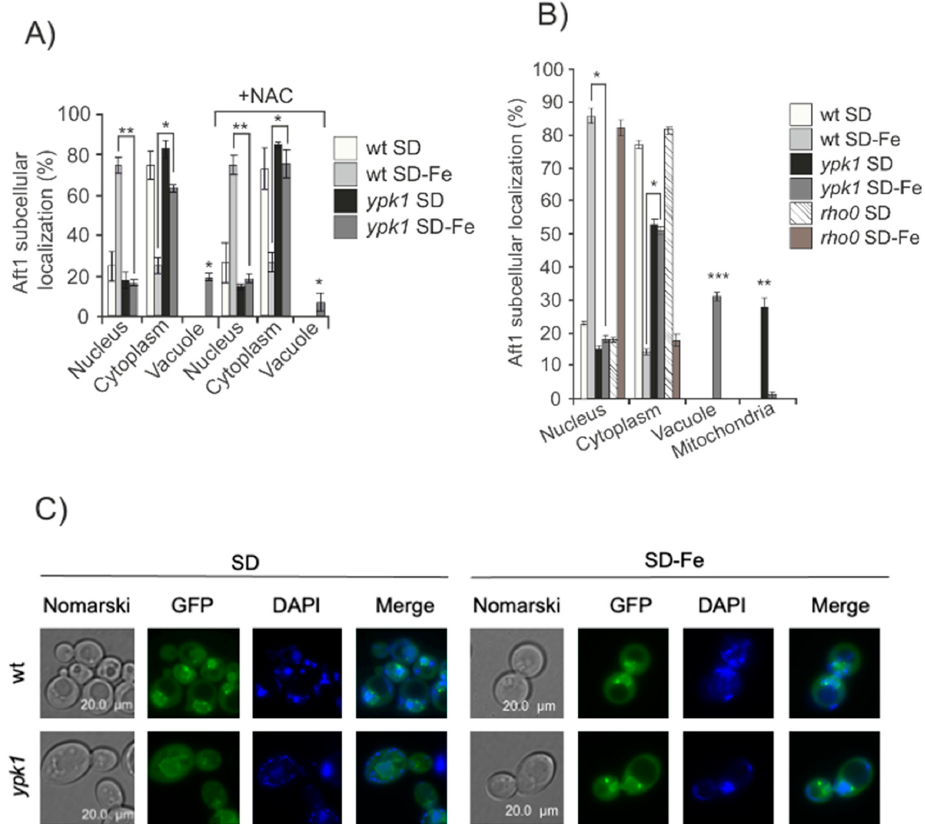
Figure 2. Aft1 miss localization in iron-starved ypk1 mutant cells was not due to oxidative stress or mitochondrial dysfunction. ( A ) wt and ypk1 cells expressing pAft1GFP were exponentially grown in SD or SD-Fe media with or without NAC overnight. Aliquots were collected for microscopic ob- servation. The histogram represents percentages of in vivo Aft1 localization. ( B ) Aft1 subcellular localization in wt, ypk1 and rho0 strains grown in the same conditions as Figure 1A. ( C ) wt and ypk1 mutant expressing pPse1GFP were grown to the log phase (OD 600 :0.6) in SD or SD-Fe medium at 30 °C. Microscopic images represent Pse1 intracellular localization. * 0.05 > p > 0.01; ** 0.01 > p > 0.001; *** 0.001 > p > 0.0001. Pse1 is the only known transporter for Aft1 which mediates its translocation from the cytoplasm to the nucleus upon iron starvation [13]. We wondered whether in the absence of Ypk1, Pse1 was precluding Aft1 nuclear localization upon iron deprivation. Pse1 was localized to the nuclear envelope (Figure 2C), independently on the presence or absence of Ypk1, both in iron depleted cells or upon iron replenishment. In conclusion, Pse1 is not involved in Aft1 localization in ypk1 mutant cells in response to iron starvation. We also considered the possibility that the signal to Aft1 nuclear localization in re- sponse to iron starvation could be originated in one of the cellular compartments where iron is stored. This would imply that one specific iron transporter would be conditioning the cellular signaling to Aft1. In order to analyze this, we made different mutants in each of the known iron transporters: Fet3: plasmatic membrane iron importer; Ccc1: vacuolar iron importer; Fet5: iron exporter from the vacuole; Mrs3: mitochondrial iron importer; Atm1: mitochondrial exporter of iron-sulfur clusters. Aft1 localization in all the mutants tested was equivalent to that determined in wt cells growing in SD-Fe (Figure 3). These observations lead us to conclude that iron accumulation in specific cellular compartments